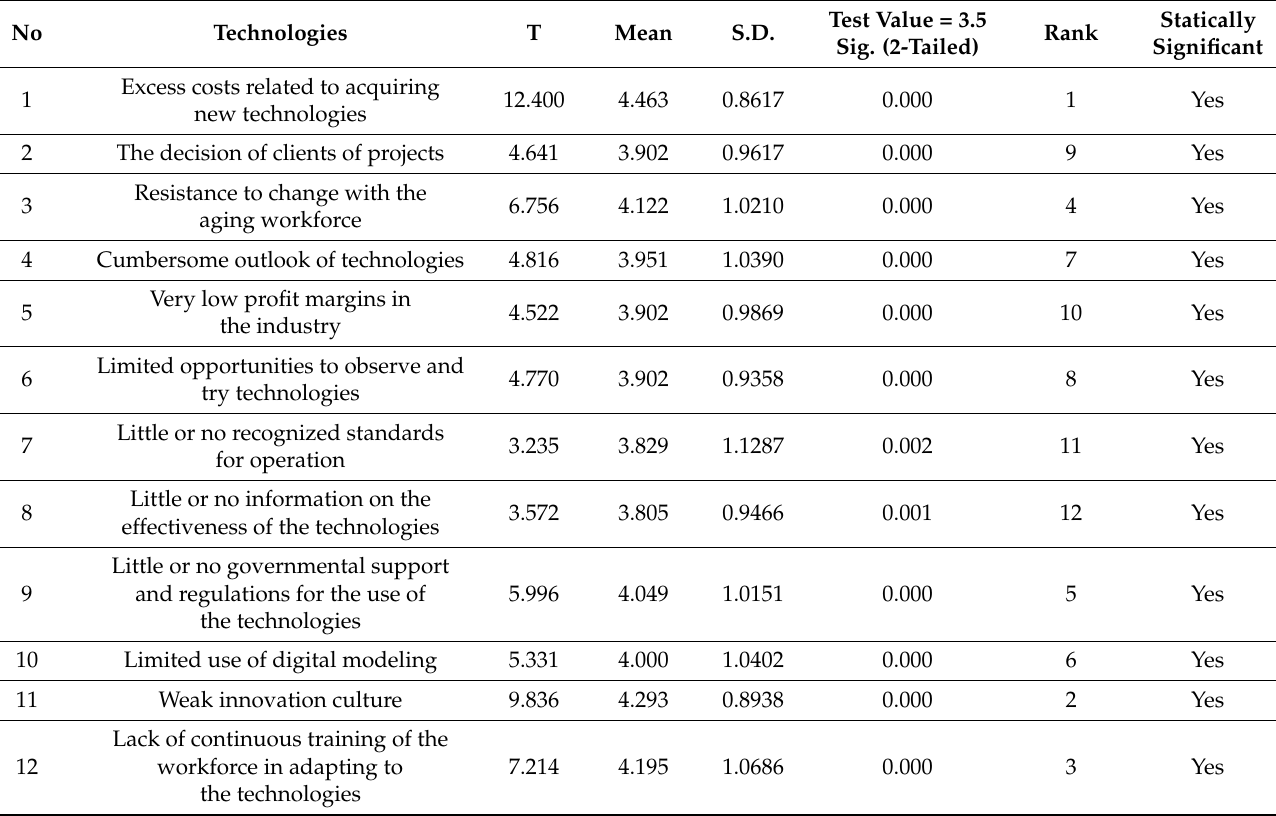
Table 4. Barriers to the adoption of current health and safety technologies in the construction